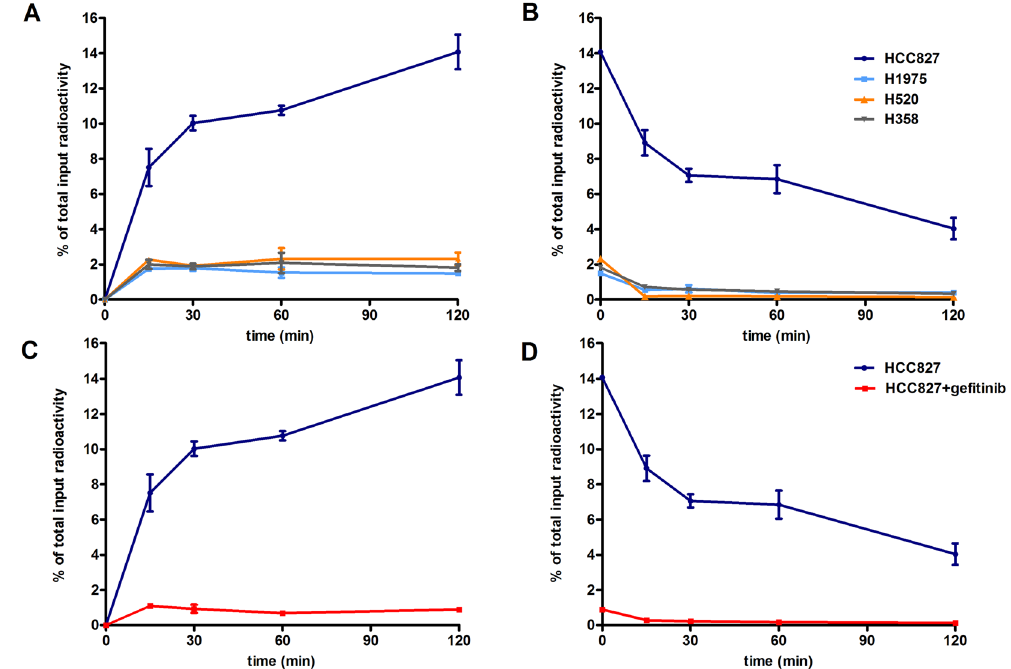
uptake of 18 F-IRS in HCC827 was higher than others H1975, H520 and H358 cell lines at all time. ( B ) Time- dependent efflux of 18 F-IRS in four cell lines (n = 3). Specificity of 18 F-IRS binding with mutated EGFR in HCC827 cells. ( C ) A dramatic inhibition of cell uptake in HCC827 was observed in the presence of gefitinib (100 µ mol/L). ( D ) Efflux of 18 F-IRS in HCC827 cell line unblocked and blocked by gefitinib. Data are presented as means ±